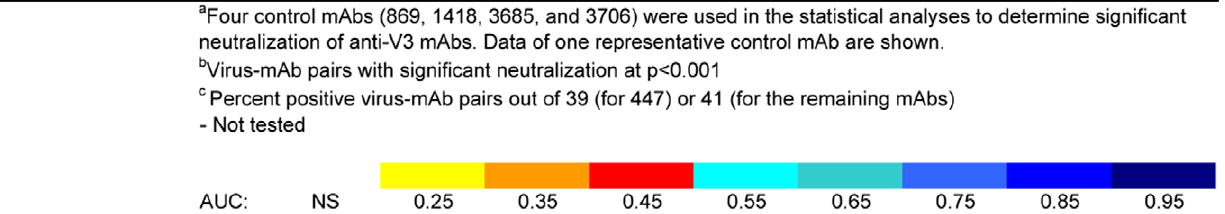
independent laboratories, and utilizing neutralization assays with different target cells, this study has demonstrated the ability of human anti-V3 mAbs to neutralize diverse HIV-1 strains from